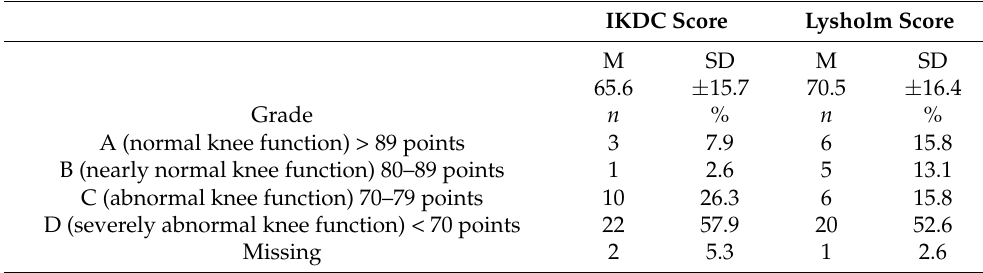
Table 2. The relevant outcome data from the study group.